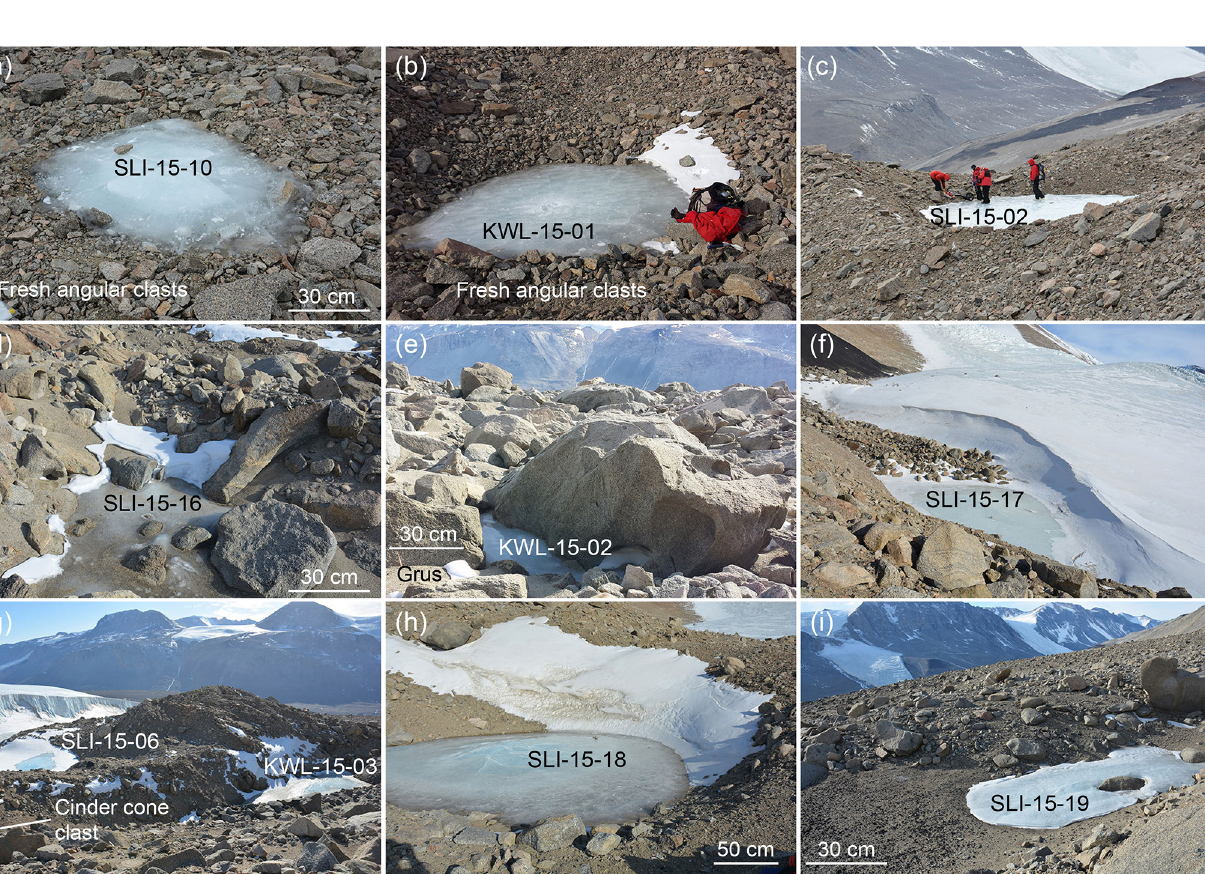
Figure 5. Field images of the 10 sampled meltwater ponds along a longitudinal transect down the rock glacier. (a) SLI-15-10 (b) KWL-15- 01, (c) SLI-15-02, (d) SLI-15-16, (e) KWL-15-02, (f) SLI-15-17, and (g) SLI-15-06 (on left) and KWL-15-03 (on right), (h) SLI-15-18, and (i) SLI-15-19. Pond SLI-15-17 occurs between the rock glacier margin and Sollas Glacier. Note the fresh appearance of granites surrounding KWL-15-01 and SLI-15-10 and the grussified ground surface surrounding KWL-15-02 and SLI-15-16 and SLI-15-18.